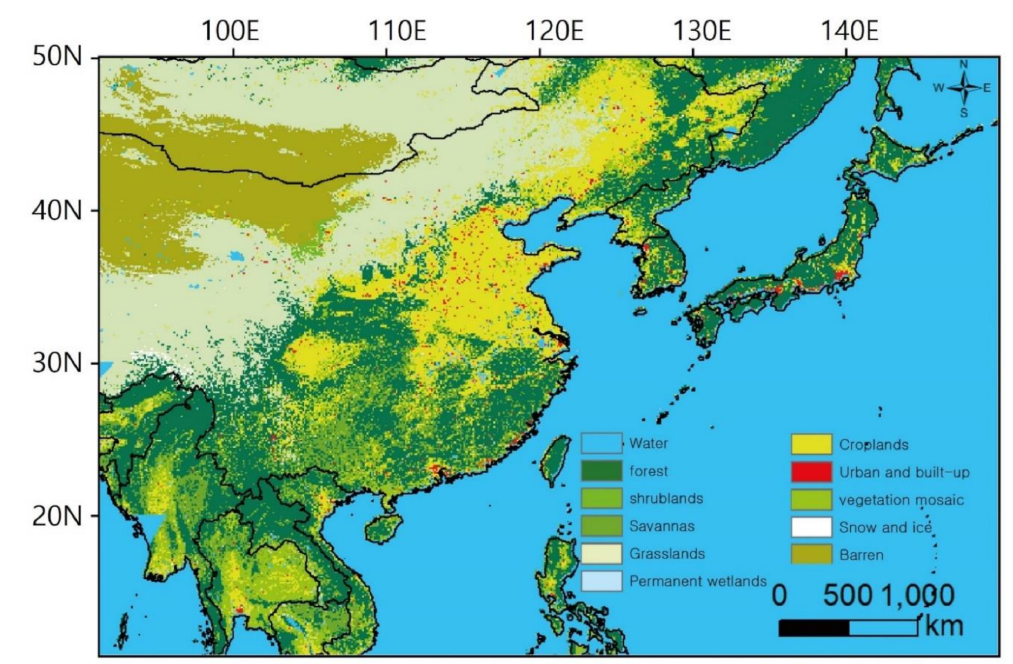
Figure 1. Study area with Moderate Resolution Imaging Spectroradiometer (MODIS) land-cover 2010 data. The representative 11 land-cover classes were aggregated from MODIS land-cover data that consists of 16